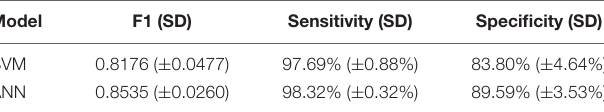
TABLE 4 | Model metrics.